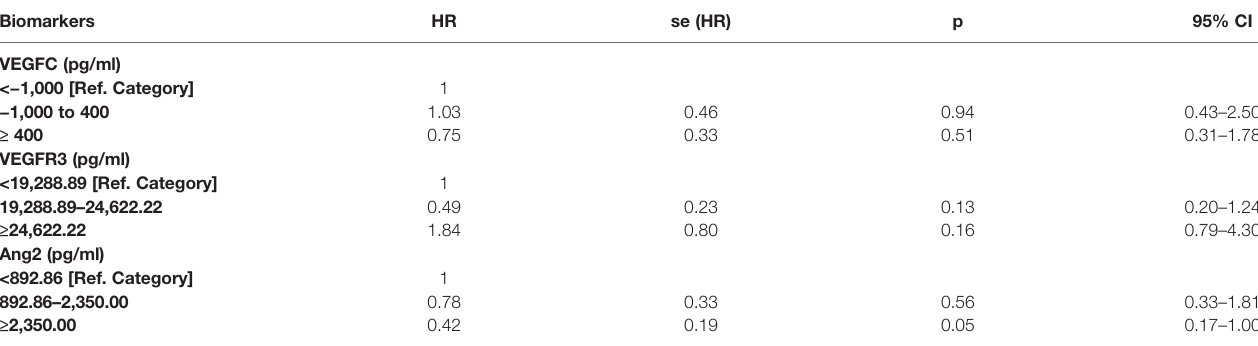
TABLE 5 | Correlation between marker changes at time T 3 and therapy outcome.